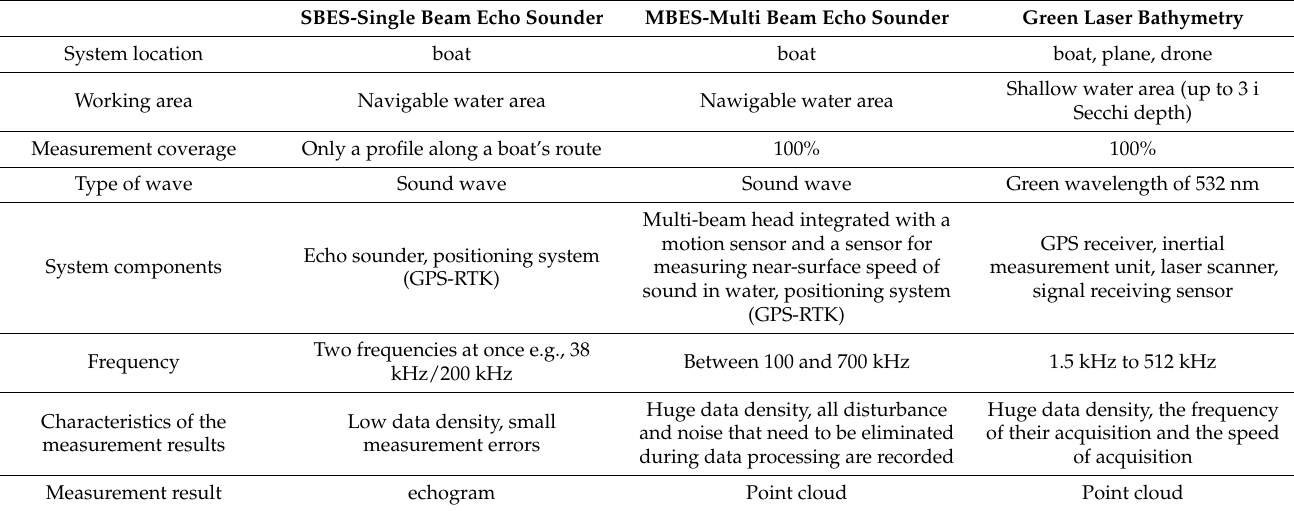
Table 1. Technical comparision of sounding bathymetry